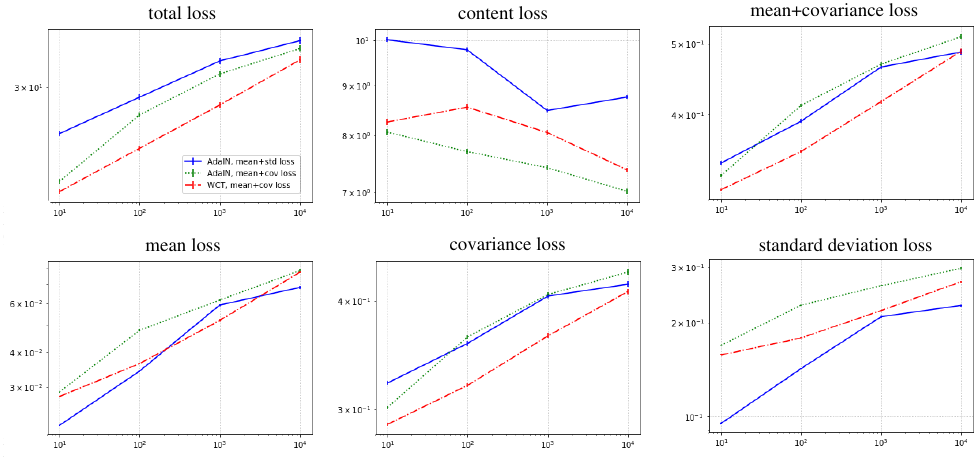
Figure 4. Comparison of the network capacity: loss performance versus the number of training